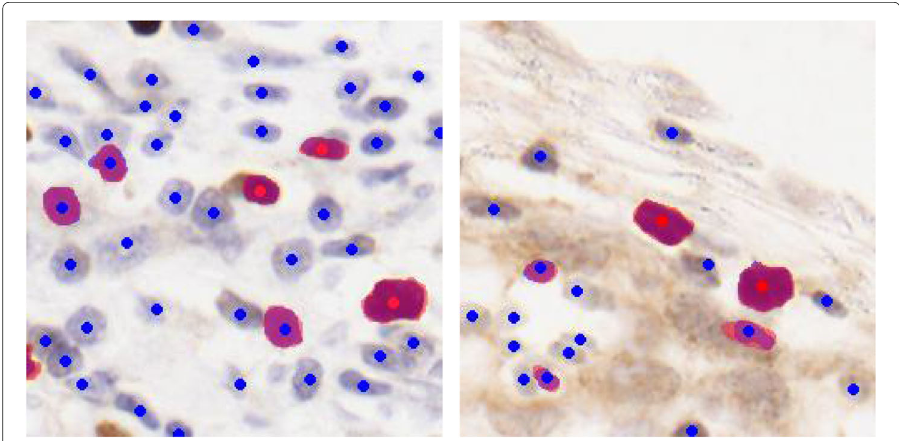
Fig. 1 Two examples of images from dataset with annotations by experts. Positive nuclei are marked with red dots while blue dots represent negative nuclei. The selected nuclei with boundary annotation are shown with blue and red overlay for each expert’s marking which results with pink